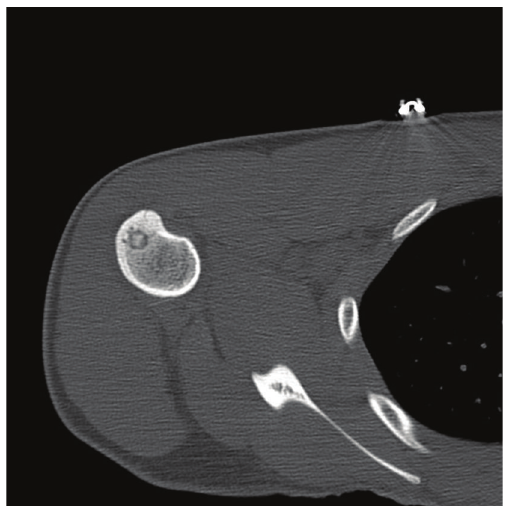
Figure 1: A Typical CT radiographic appearance of an osteoid osteoma in the proximal